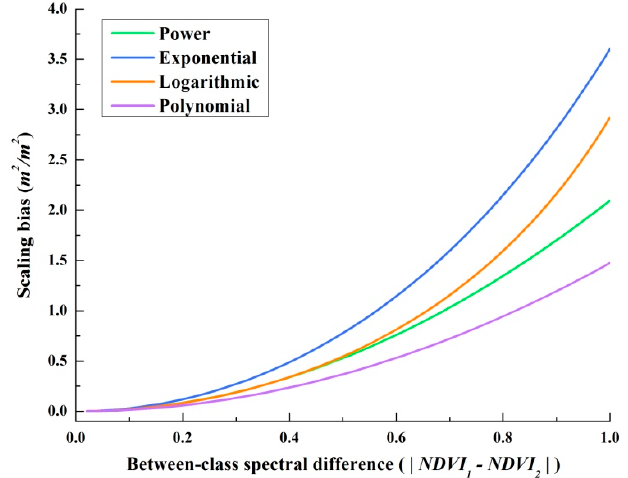
Figure 8. The relationship between scaling bias and differences of classes ( NDVI 1 and NDVI 2 ) within a coarse pixel.